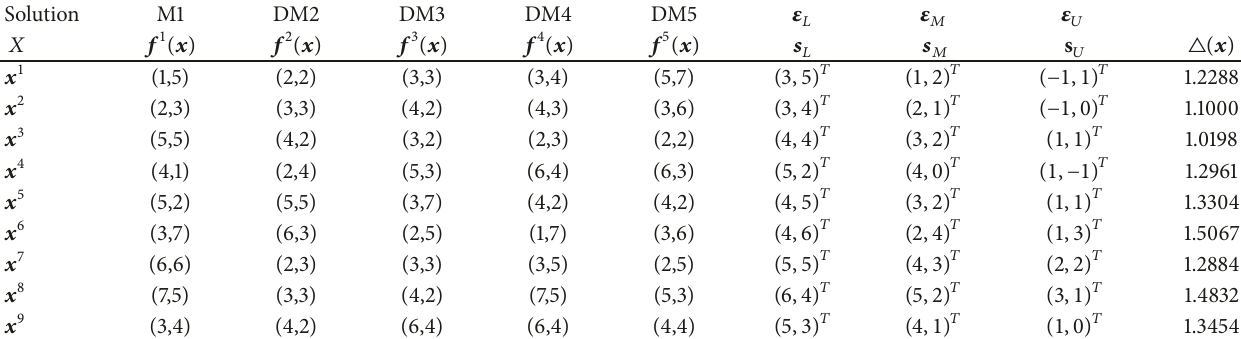
Table 2: The scores of 9 candidates and the equilibrium value under triangular fuzzy target concession values. Solution